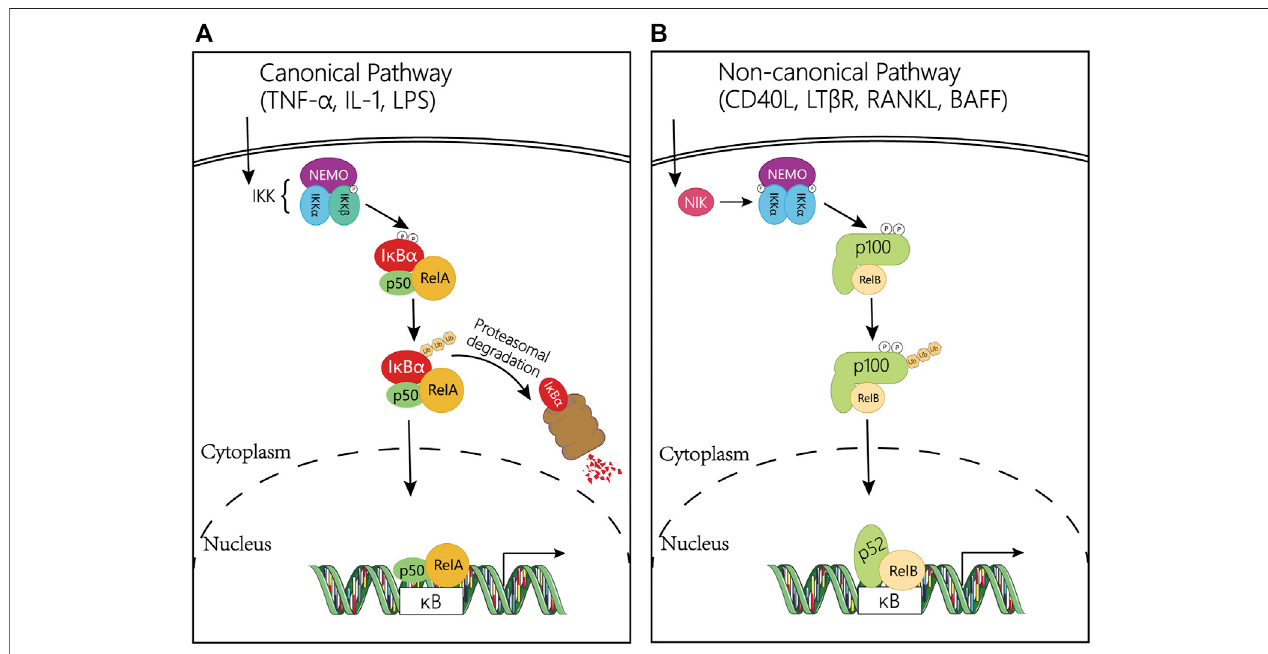
FIGURE 2 | Regulation mechanism diagram of NF- κ B pathway. ( A) Canonical NF- κ B signaling pathway. The classical pathway is triggered by TNF α , IL-1, or LPS, and subsequently activates the I κ K complex, which induces phosphorylation of I κ B α and promotes its degradation. This leads to the release of the NF- κ B heterodimer RelA/p50,whichthentranslocatestothenucleusandinducesthetranscriptionoftargetgenes.( B) Non-canonicalNF- κ Bsignalingpathway.Thispathwayisactivatedby CD40L, LT β R, RANKL and BAFF gene, and mediated by NIK and the I κ K complex containing two I κ K α subunits, but not NEMO. In the non-canonical pathway, receptor binding leads to activation of the NF- κ B-inducible kinase NIK, which phosphorylates and activates the I κ K α complex, which in turn phosphorylates two serine residuesadjacent totheC-terminalI κ Bdomain ofthep100ankyrin repeat,resultinginitspartialproteolysisandreleaseofthep52/RelBcomplex.Abbreviations:NF- κ B, Nuclear Factor-kappa B; TNF α : tumor necrosis factor α ; IL-1: interleukin-1; LPS: lipopolysaccharide; I κ B, an inhibitor of κ B; I κ K, I κ B kinase; CD40L, CD40 ligand; RANKL, receptor activator of nuclear factor kappa-B ligand; LT β R, lymphotoxin beta; BAFF, B cell-activating factor; NIK, NF- κ B inducing